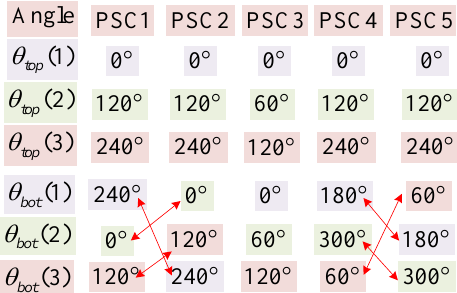
Figure 6. Carrier angles of each submodule (SM) for five PSC-SPWM schemes when N =